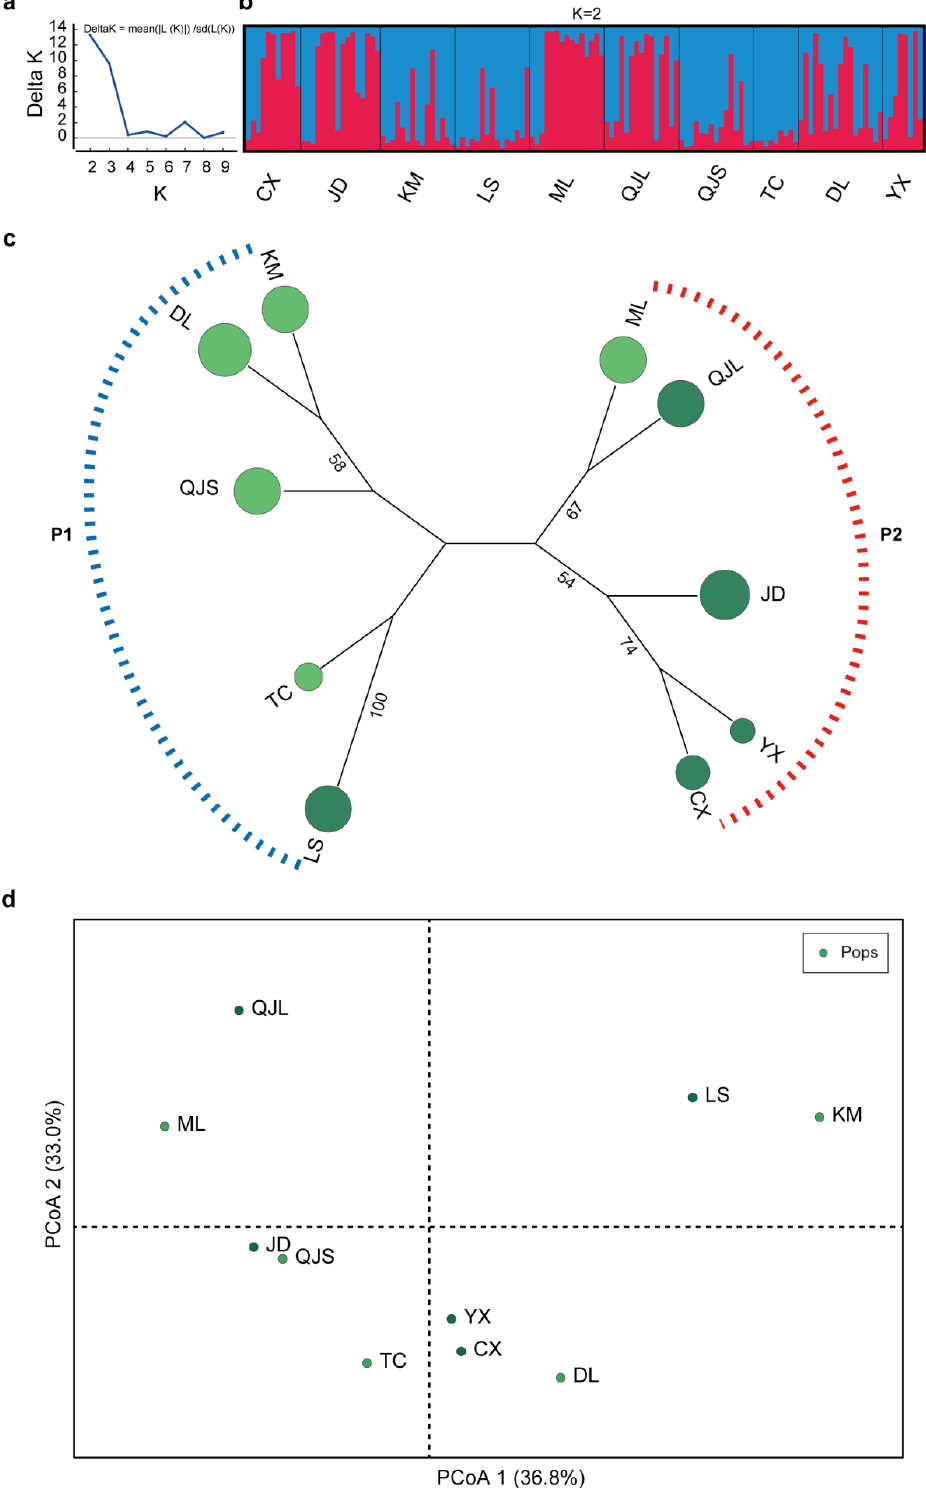
Figure 4. The population genetic structure of P. polyphylla var. yunnanensis . ( a ) relationships between the number of clusters ( K ) and the corresponding log probability of the data L( ∆ K ); ( b ) assignment of individuals to K = 2 genetically distinguishable group. ( c ) genetic divergence of 10 populations based on UPGMA cluster analysis. The two cultivated populations are denoted with dark green and light green. ( d ) principal coordinate analysis (PCoA) of 10